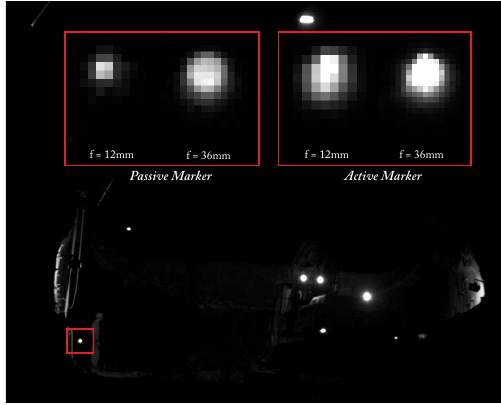
Figure 3. Blobs at 50 m distance with minimal/maximal focal length of f = 12 / 36